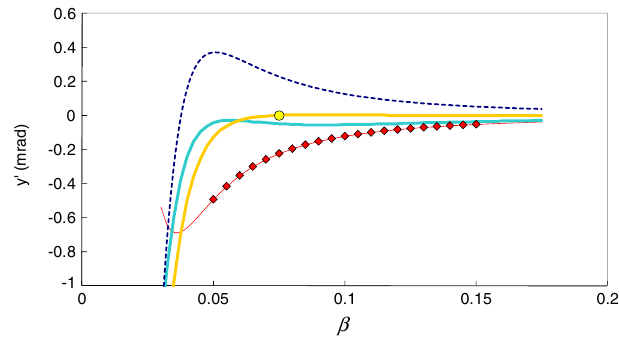
FIG. 11. Steering in a 106 MHz, (cid:1) ¼ 0 : 075 at 1 MV = m , q=A ¼ 1 and (cid:2) ¼ (cid:1) 30 (cid:6) , calculated with expression (15). Red line: model without correction; red diamonds: particle tracking without correction; blue line: corrected with 0.7 mm axis dis- placement; yellow line: corrected by optimizing the G parameters. The dashed line represents the contribution of the correcting field component generated by the tilted beam ports.